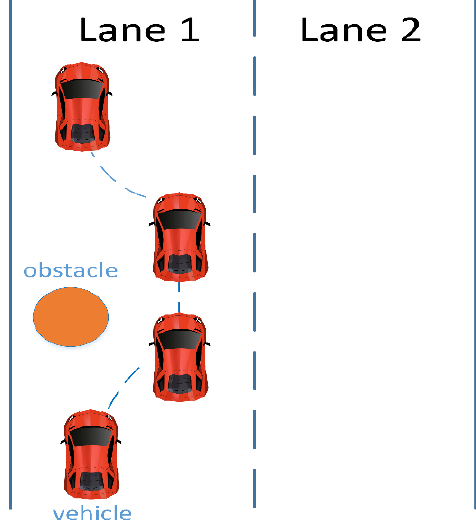
Figure 4. Vehicle avoidance obstacle schematic.